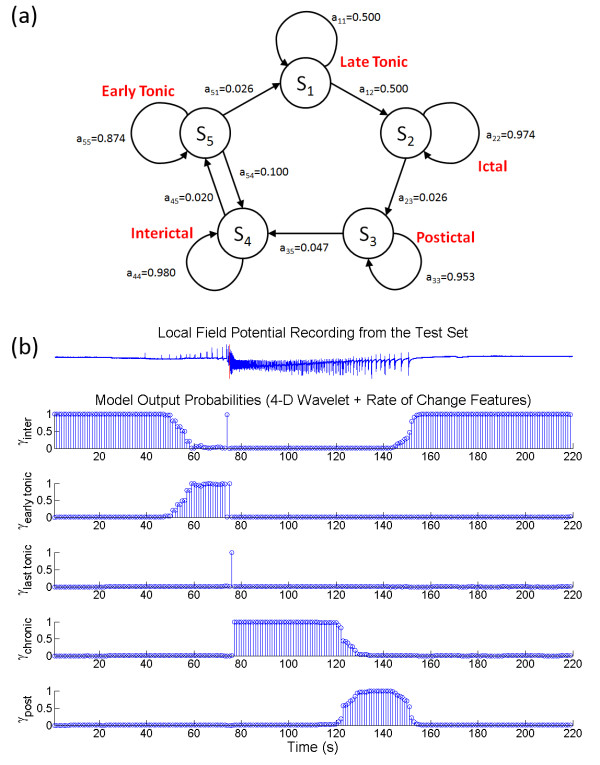
The transition diagrams and the posterior probabilities of the reduced feature space after mRMR and AICc. (a) The state transition diagram for HMMAIC is given. Similar to the HMMopt14D, the some early tonic activity permissive to seizures is allowed to return to the interictal state. Between the late tonic firing and postictal state, the transition follows a unidirectional progression. (b) The mapping of HMMAIC states to the electrophysiological LFP is shown. In this illustrative example, the marginal probabilities of the model states follow a progression from non-ictal, tonic firing to chronic seizures and postictal state, before returning to non-ictal. The late tonic firing state in this model is typically shorter than the model from Figure 5b because of the significantly smaller transition probability back to itself.